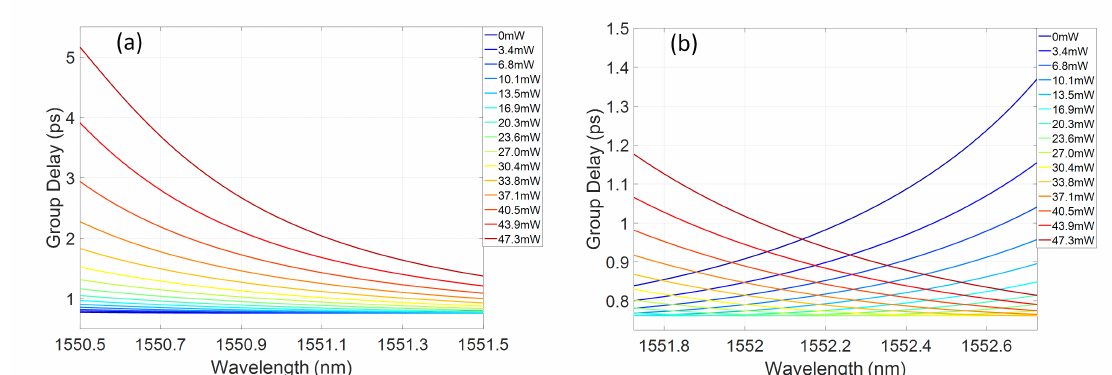
Figure 7. Simulated group delay bands as a function of dissipated power on the heater centred at: ( a ) 1551nm; and ( b ) 1552.2mn.